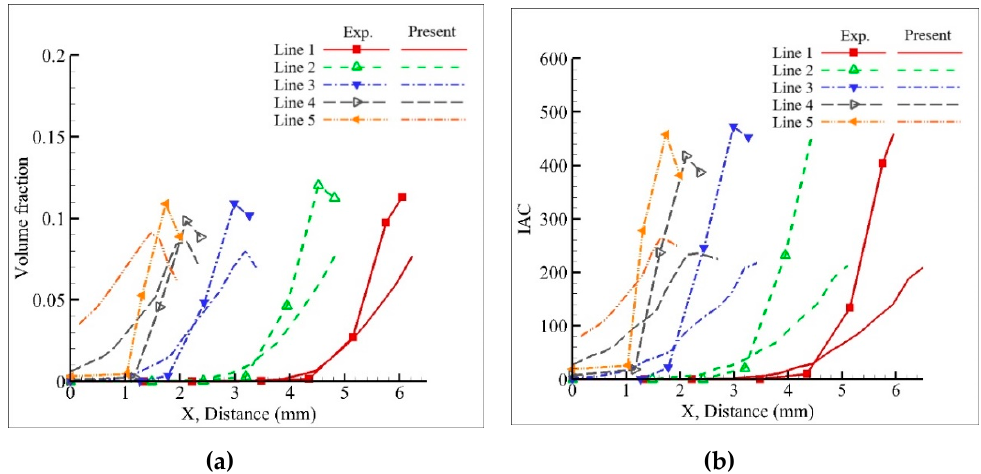
Figure 9. Case 3 numerical results of Lines 1–5 compared with experiment results: ( a ) volume fraction and ( b ) interfacial area concentration.